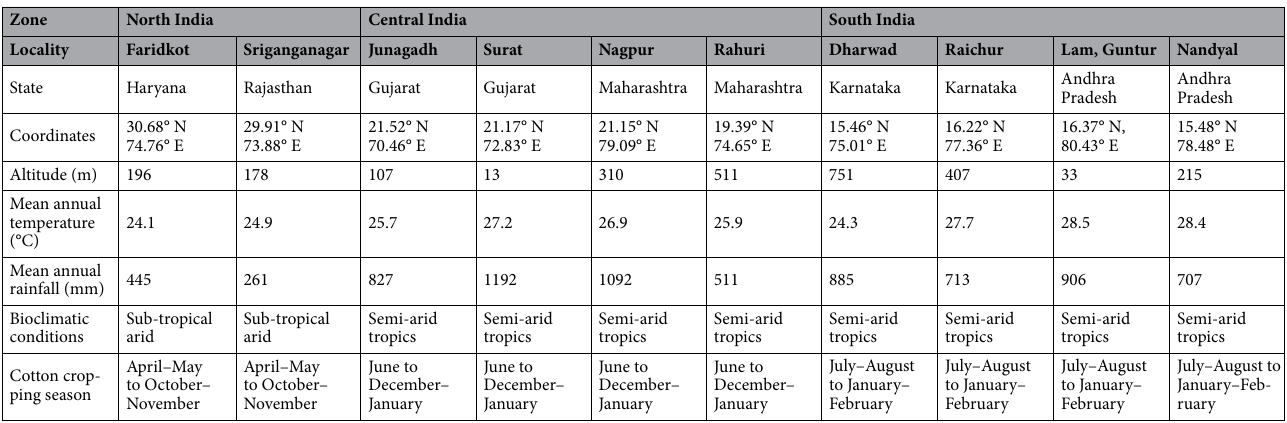
Table 6. Characteristic features of sampling sites in relation to pink bollworm